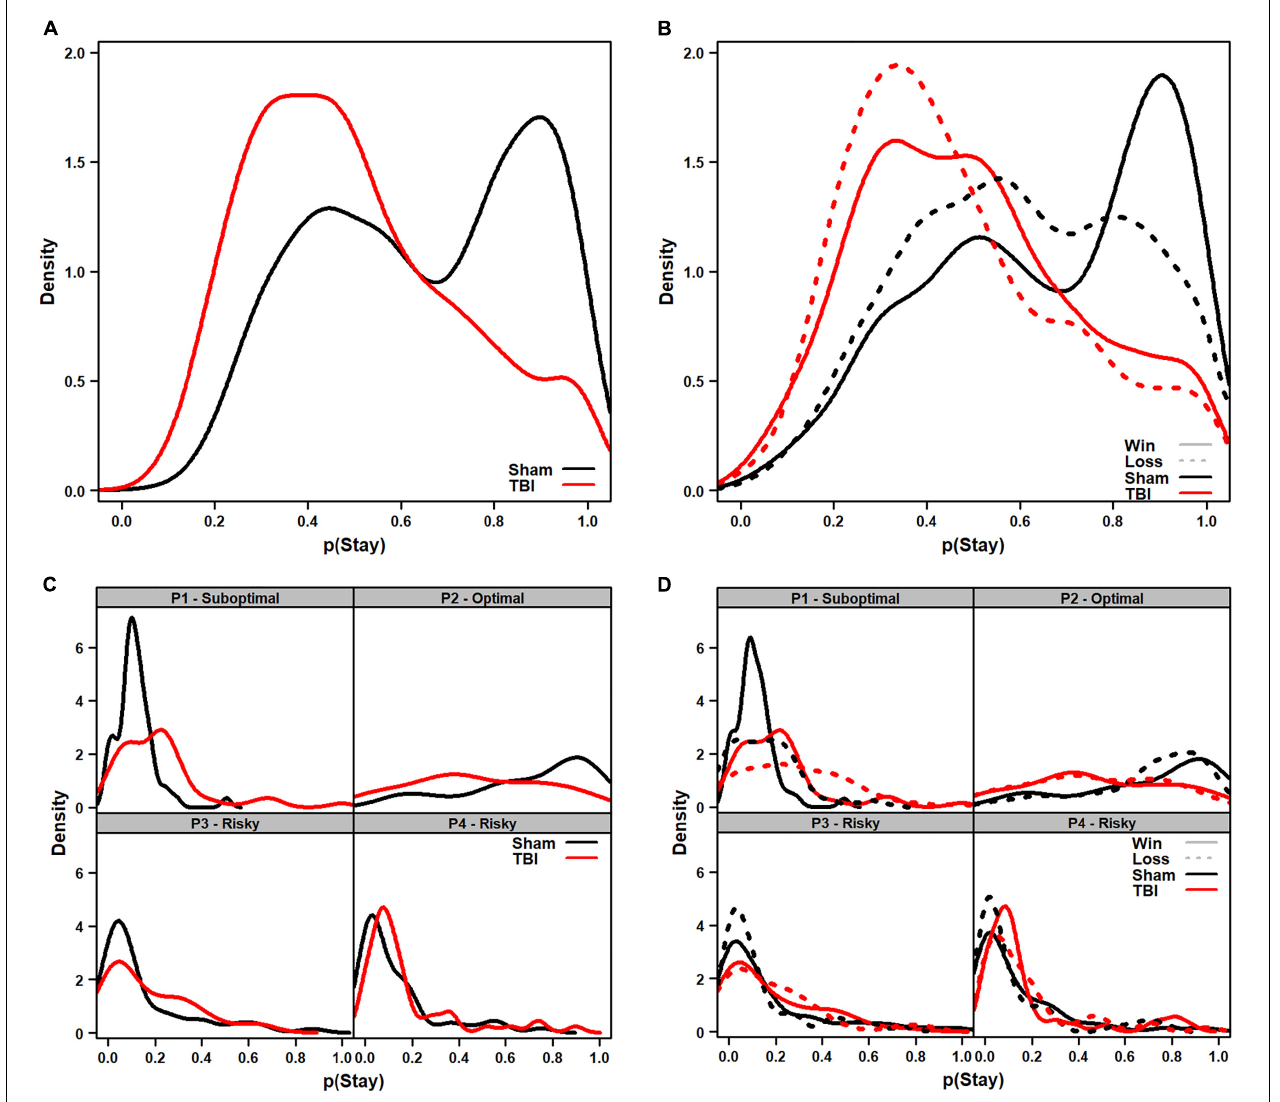
FIGURE 4 | Density plots of distributions of the probability of staying with a choice in TBI vs. Sham animals. (A) Overall tendency to stay on a choice (regardless of outcome) was higher in Sham than TBI rats ( p = 0.008). Sham rats displayed a bimodal set of peaks around 40 and 90% likelihood of staying on an outcome. (B) Breakdown of tendency to stay depending on whether the prior outcome was a win (solid) or loss (dashed). The same overall differences were present in TBI ( p = 0.008), and losses reduced the probability of staying (leftward shift in curve; p = 0.016) but TBI rats did not show differential sensitivity to wins or losses ( p = 0.966). (C) When broken down to each choice option, TBI rats were more likely to stay with P1 ( p = 0.001), but less likely to stay with P2 ( p < 0.001) regardless of outcome. (D) When choice option data were analyzed depending on whether prior outcome was a win (solid) or loss (dashed), similar overall effects in tendency to stay were observed with TBI rats more likely to stay with P1 ( p < 0.001) and P4 ( p = 0.021), but less likely for P2 ( p < 0.001). There were no differential effects in sensitivity to wins vs. losses ( p ’s >